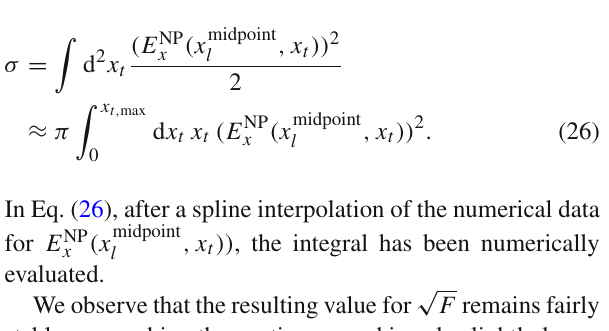
Table 2 Summary of the numerical determination of the (square root of the) force, Eq. (18) and the (square root of the) stress tensor Eq. (26); the last four columns give the edges of the integration domains. See the text for how the assessment of systematics on √ √ β σ [GeV] x F [GeV] l , min [fm] x l , max